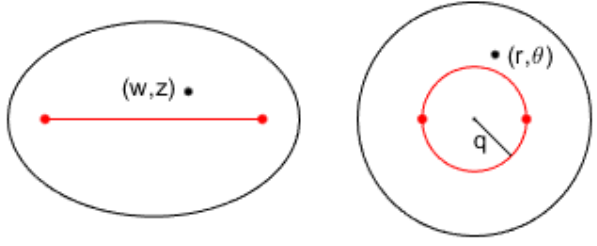
Figure 1. The transformation (9) maps the ellipse E ino the annulus of radii ( q ,1 )